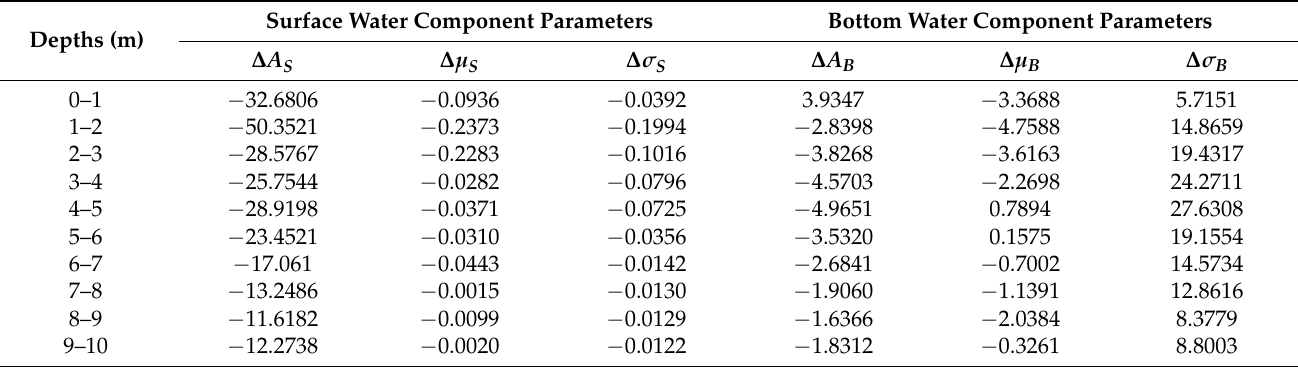
Table 4. Changes in the surface- and bottom-water waveform parameters before and after LM optimization. Depths